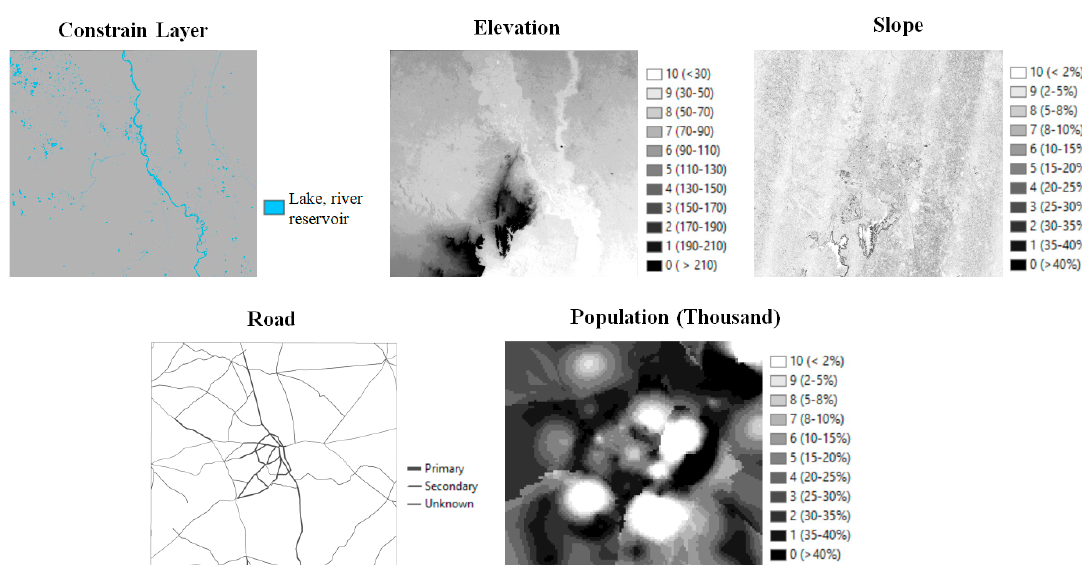
Figure 4. The example maps that were used to create the suitability drivers and constrain layers.